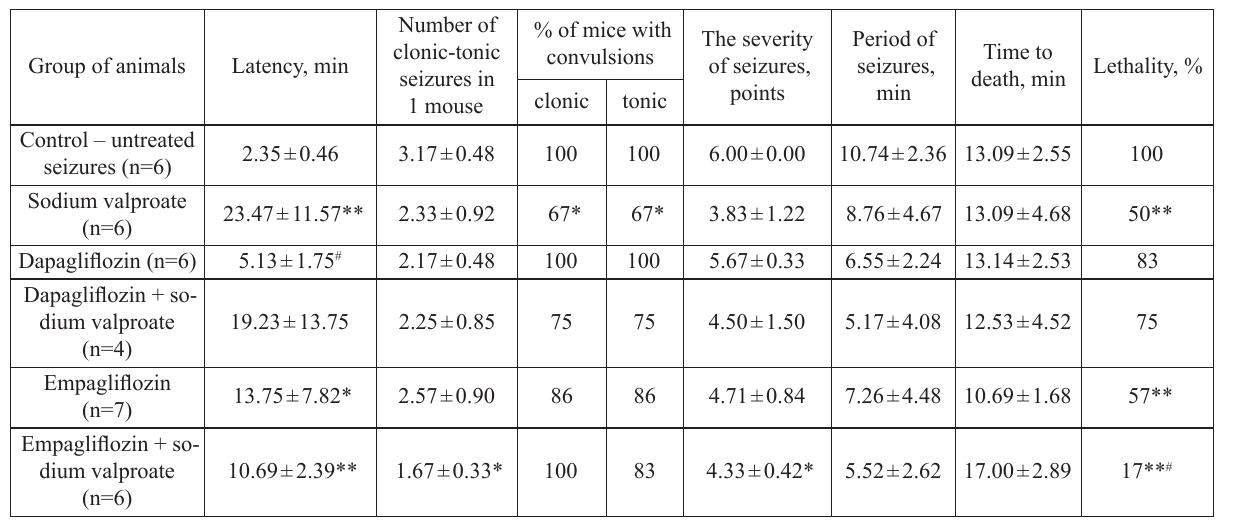
Anticonvulsant effect of dapagliflozin, empagliflozin and their combinations with sodium